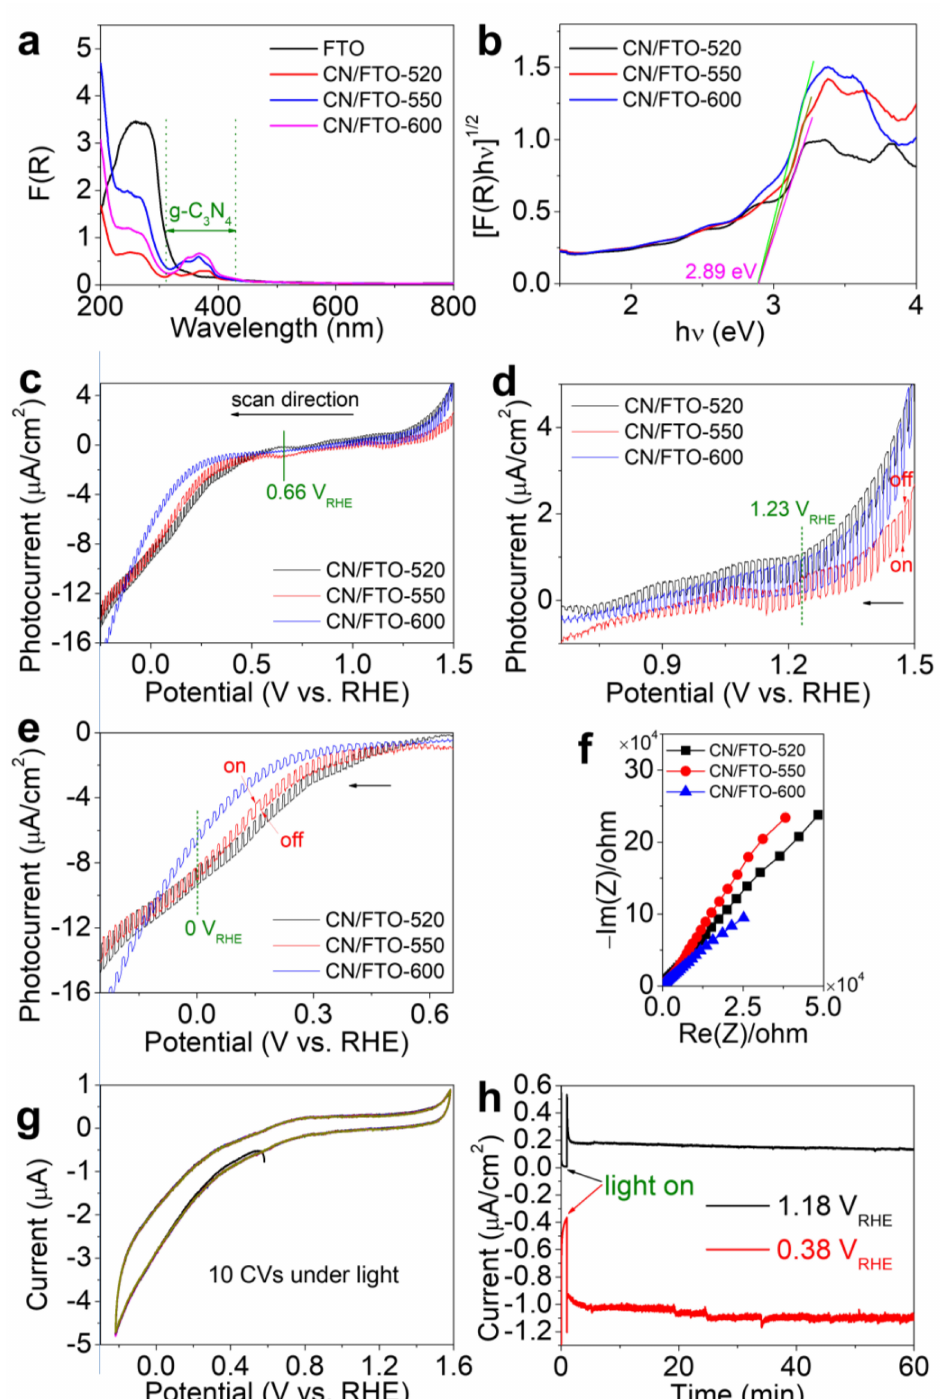
Figure 7. ( a ) DRS and ( b ) their corresponding Tauc plots (( F ( R ) h ν ) 1/2 versus h ν for the indirect band gap), photocurrent I–V curves ( c ) from 1.5 to − 0.25 V RHE , ( d ) from 1.5 to 0.66 V RHE , and ( e ) from 0.66 to − 0.25 V RHE , ( f ) EIS spectra of CN/FTO-520, CN/FTO-550, and CN/FTO-600 films. ( g ) Cyclic voltammograms of CN/FTO-520 under 1 sun light illumination. ( h ) Photoelelectrochemical stabilities of CN/FTO-520 film checked at 1.18 V RHE and 0.38 V RHE for 1